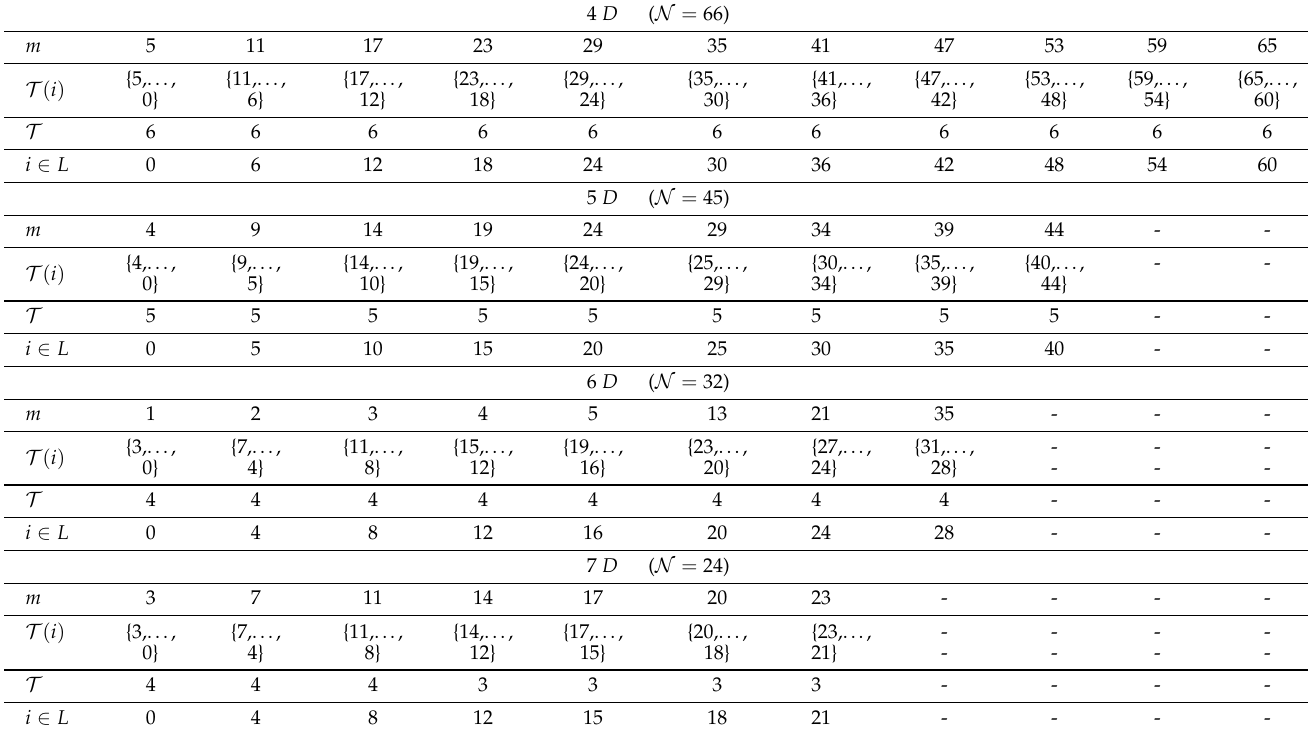
Table 5. Table showing different deployments and their set